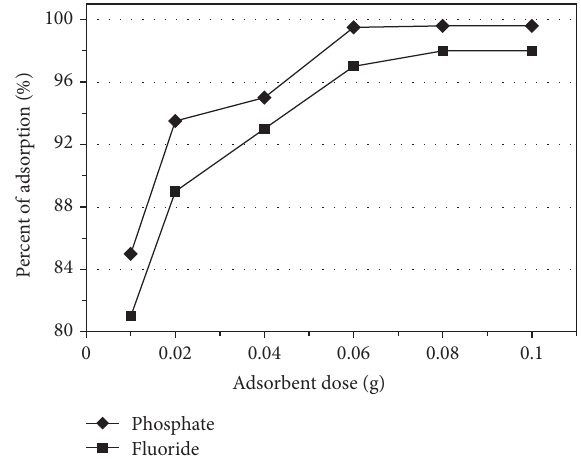
Figure 4: Effect of dosage on removal of fluoride and phosphate adsorption by